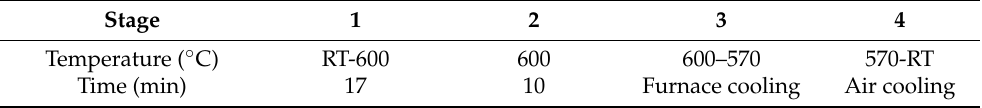
Table 3. The process of the fluidity